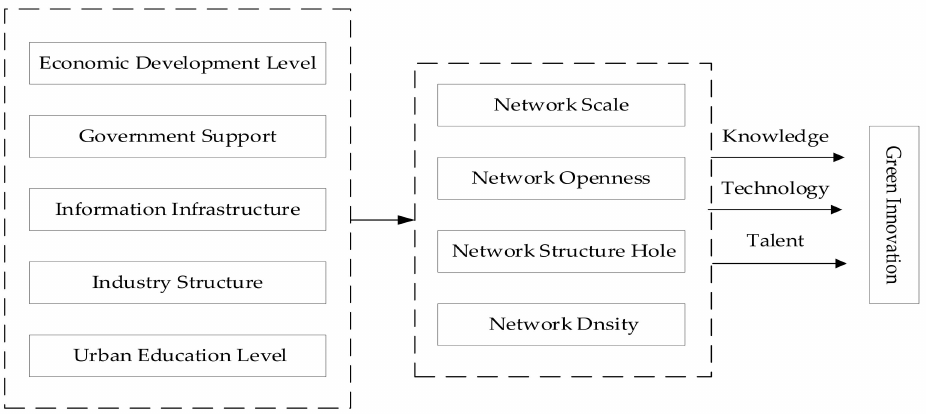
Figure 1. Influencing mechanisms of green